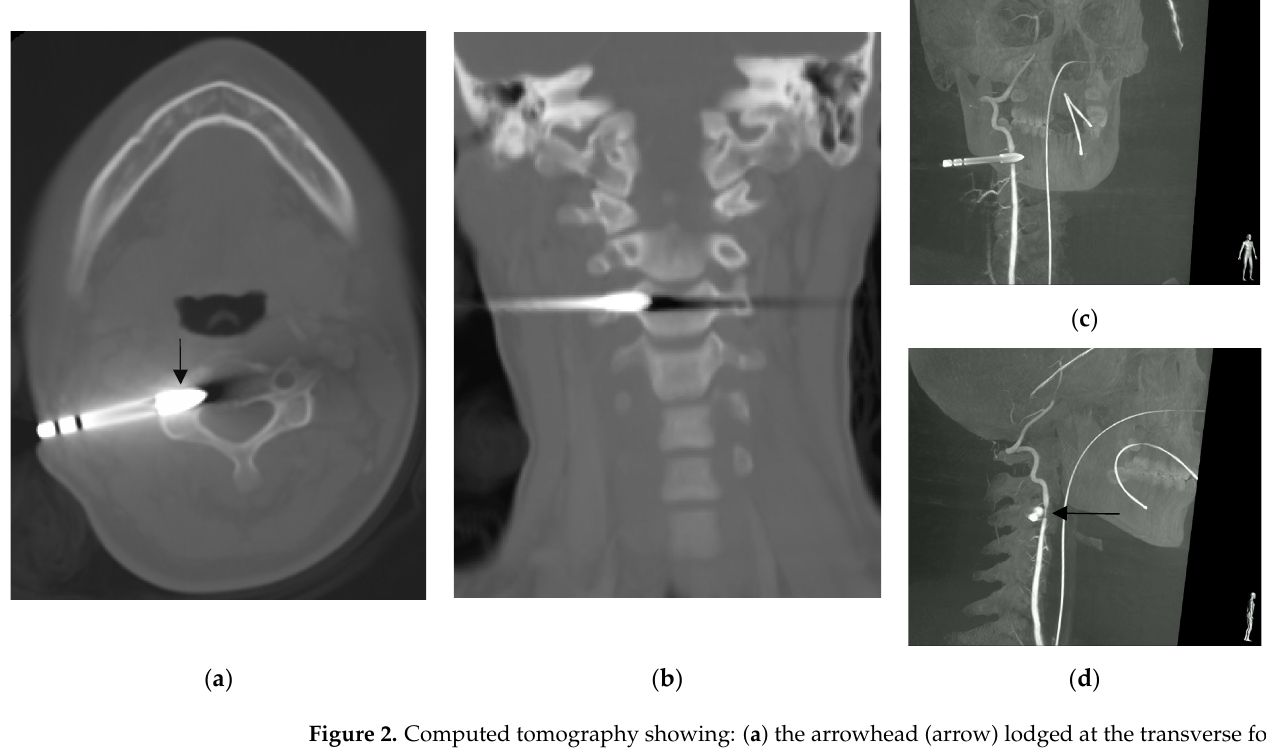
Figure 2. Computed tomography showing: ( a ) the arrowhead (arrow) lodged at the transverse foramen of third cervical vertebra without violating the central canal, and; ( b ) the coronal reconstruction of the same scan showed that the arrowhead did not violate the neural foramen. Right vertebral artery angiography rotation view ( c , d ) showed narrowing of the right vertebral artery indented by the arrowhead (arrow) [1].